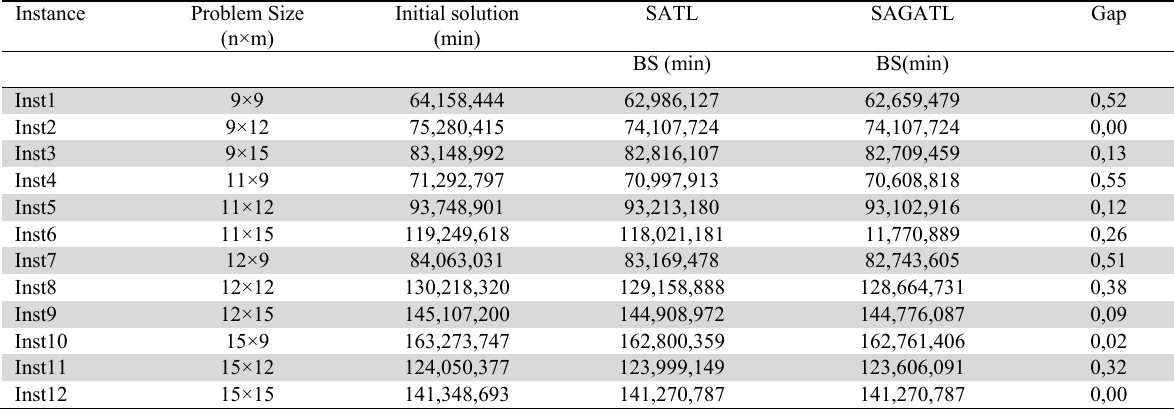
The results of the proposed algorithm and